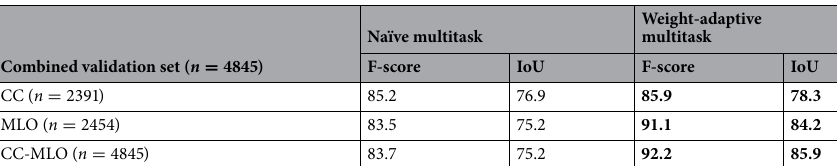
Table 2. The comparison of naïve multitask loss function with the modified weight-adaptive multitask loss function. The model trained with weight-adaptive multitask loss function shows superior performance in segmenting the breast area and the dense tissues than the naïve approach, with relative improvements of 10.15% and 14.23% in terms of F-score and IoU, respectively, on the CC-MLO-view mammograms of the combined validation sets. Best values are in